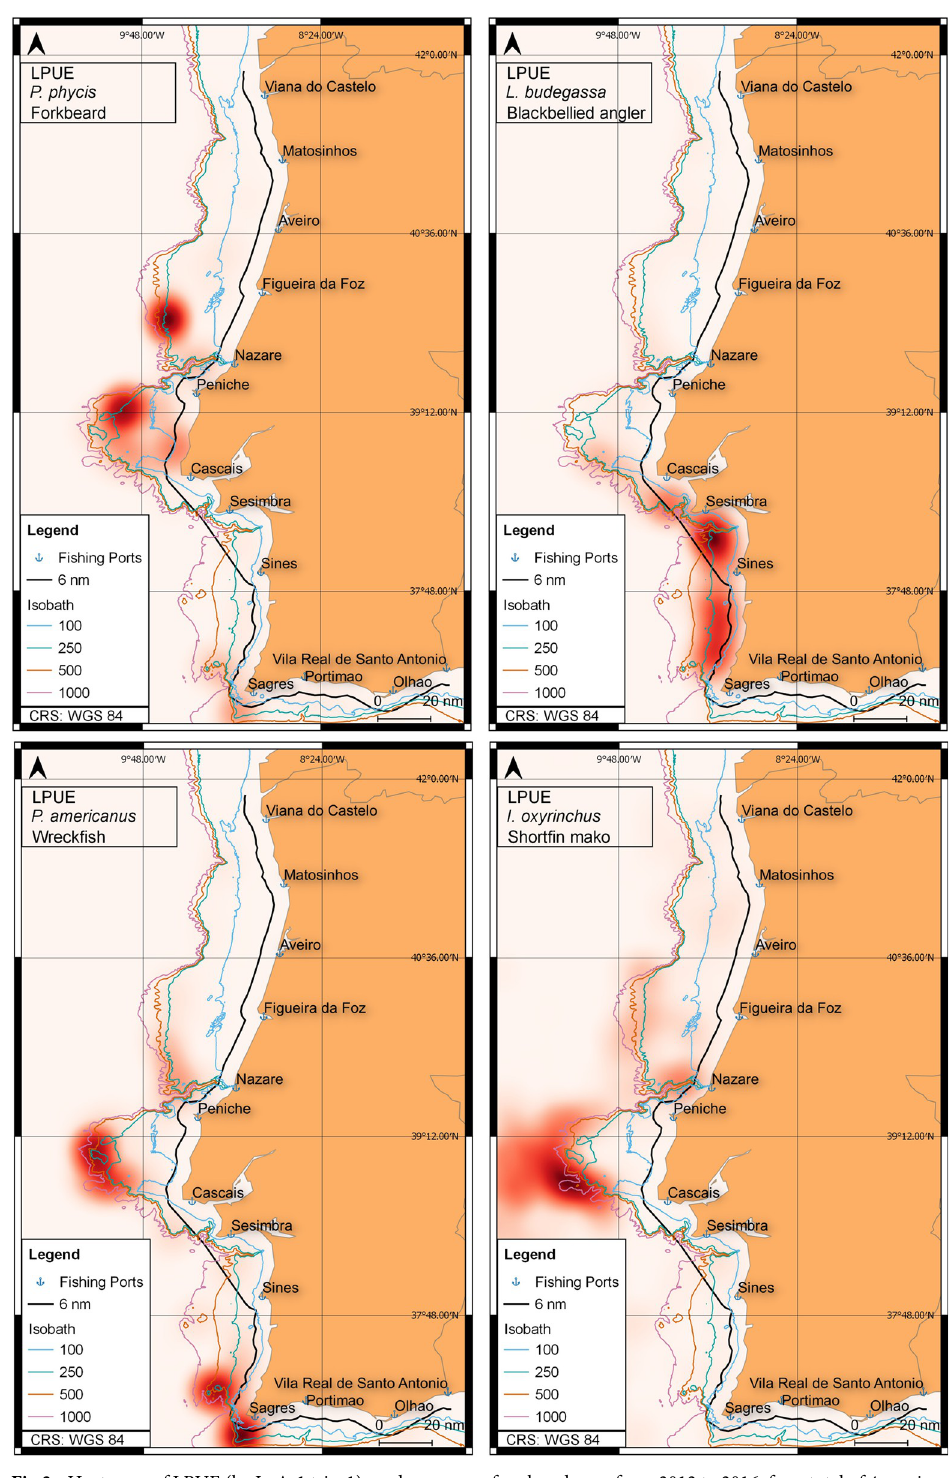
Fig 3. Heatmaps of LPUE (kg LoA-1 trip-1) used as a proxy for abundance, from 2012 to 2016, for a total of 4 species: a) forkbeard, b) blackbellied angler, c) wreckfish and d) shortfin mako. Main fishing ports are indicated as well as the 6 nautical miles line (inner limit of trawling activity). Bathymetry from the EMODnet Bathymetry Consortium [36].